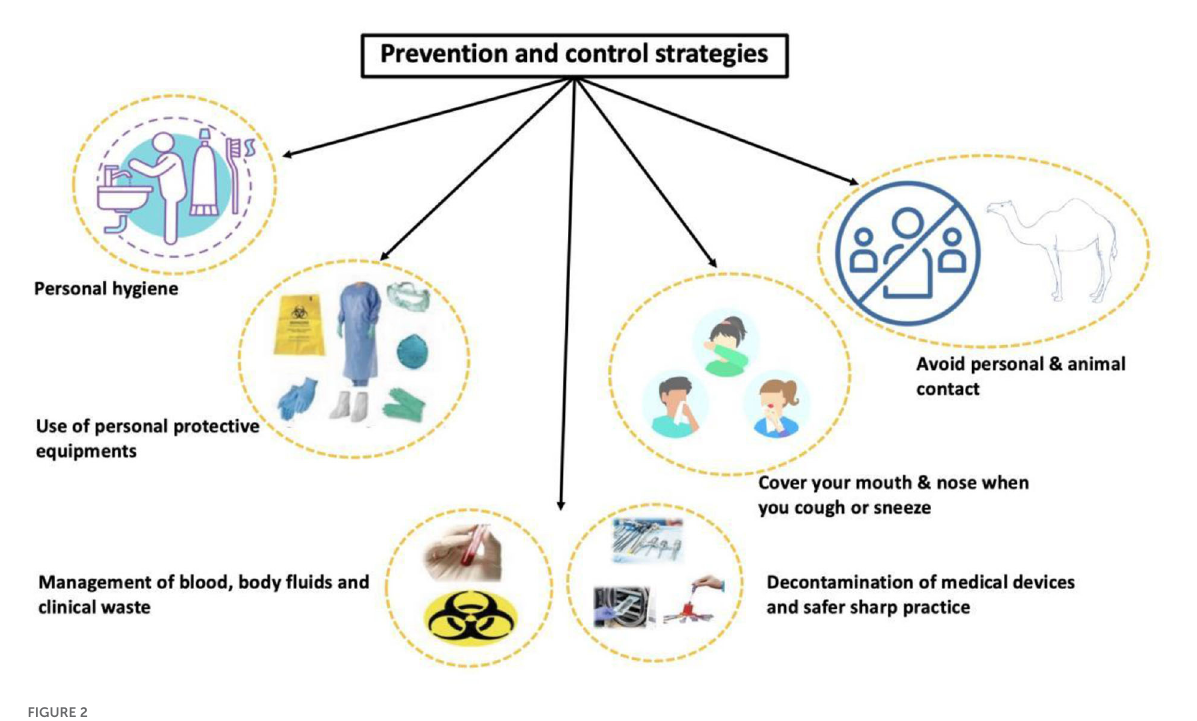
FIGURE2 Prevention and control strategies for MERS-CoV.